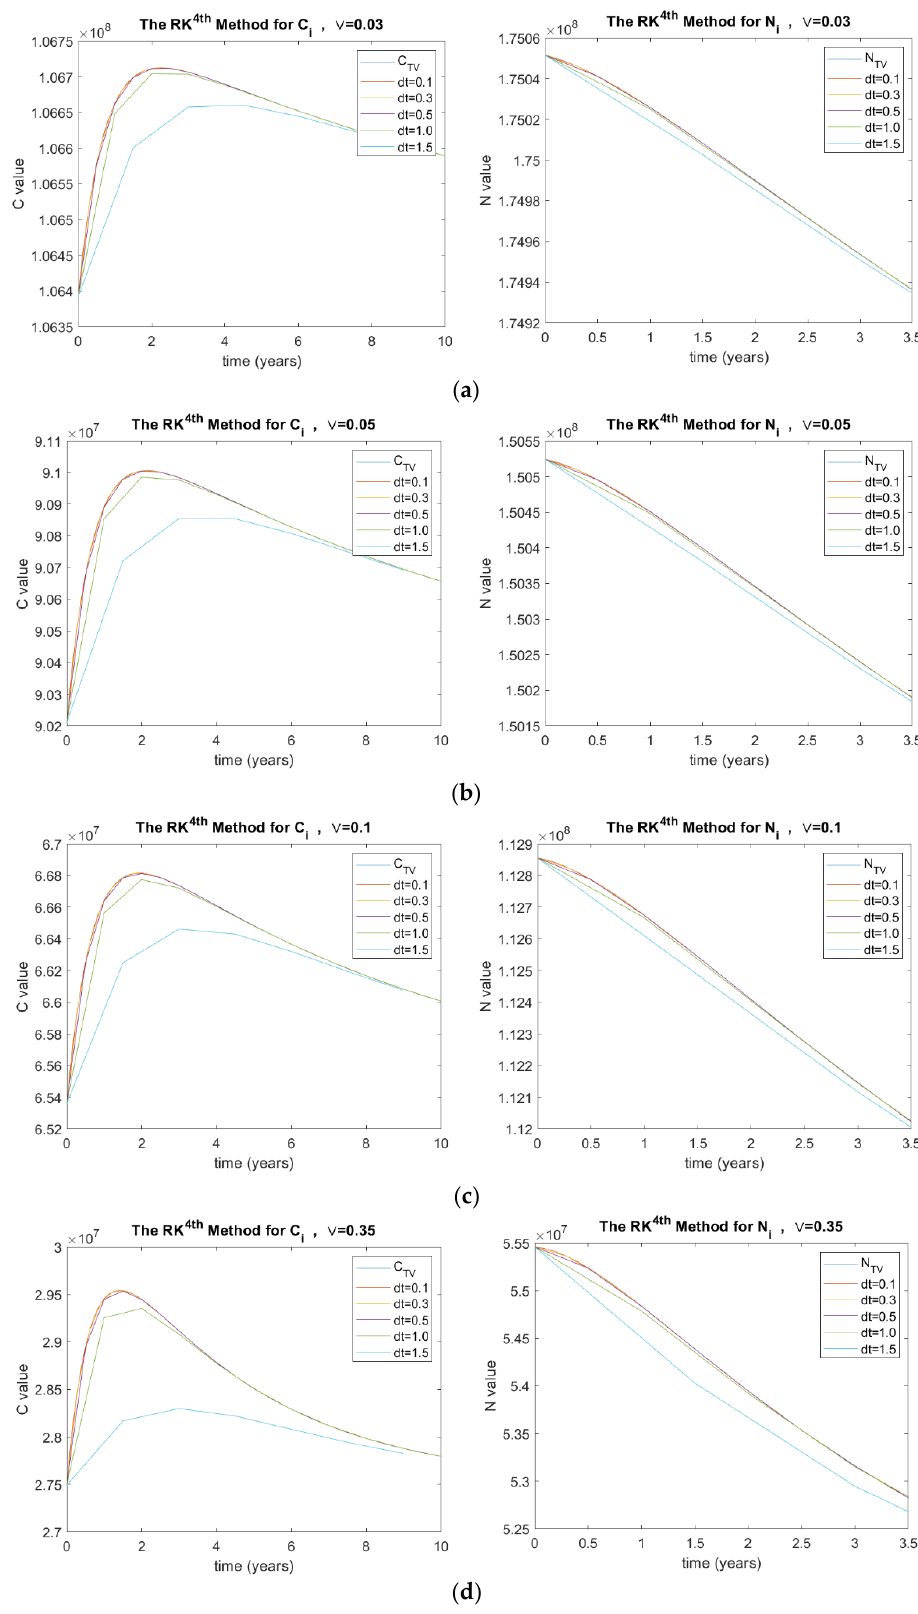
Figure 7. ( a ) Stability analysis for RK method when v = 0.03, ( b ) v = 0.05, ( c ) v = 0.1, and ( d ) v = 0.35, where C is the number of diabetic patients with complications and C TV is its true value, N is the total number of people with diabetes and N TV is its true value, and d t is the time step